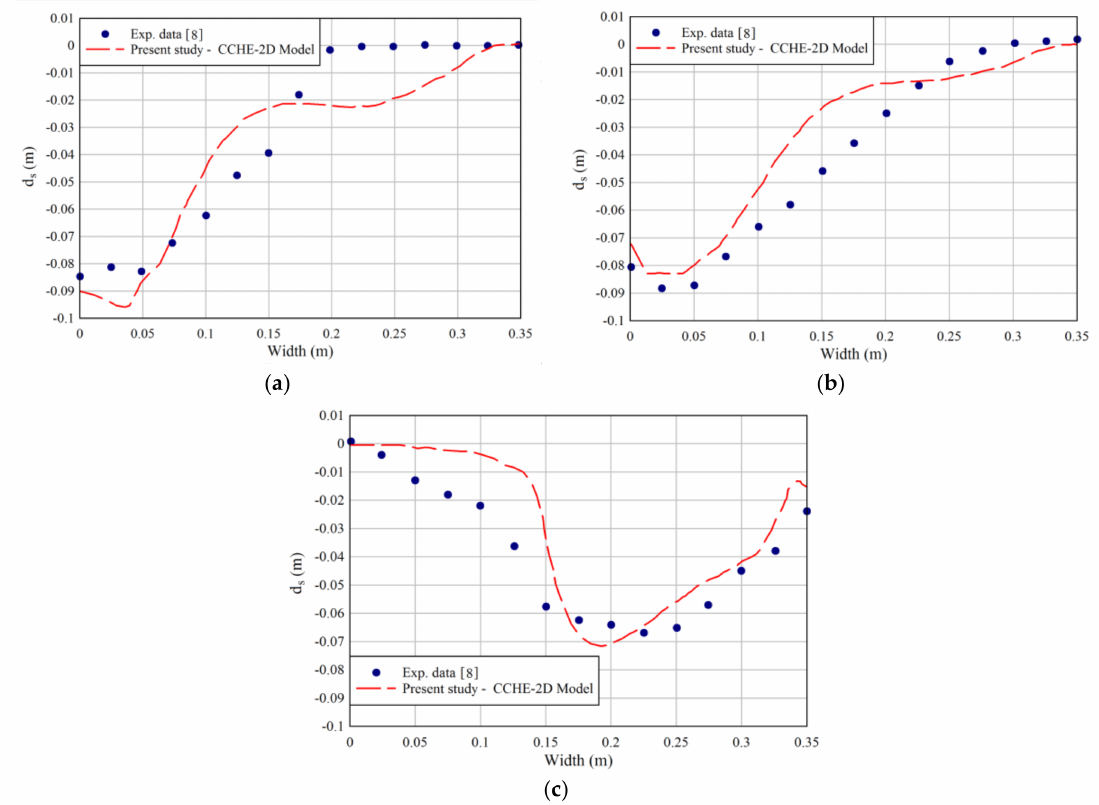
Figure 6. Comparison between experimental data and numerical results ( θ = 90 ◦ ). ( a ) Run 1; ( b ) Run 3; ( c ) Run